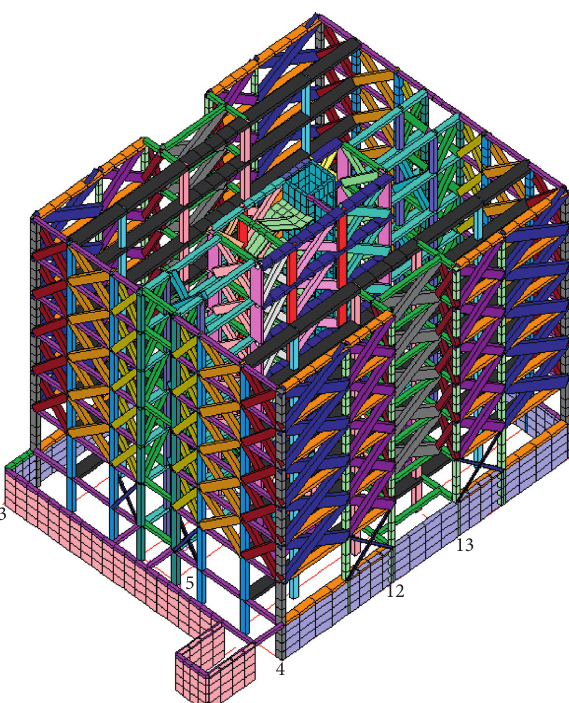
Figure 5: Geometry of the case study. Solid view of the finite element model.